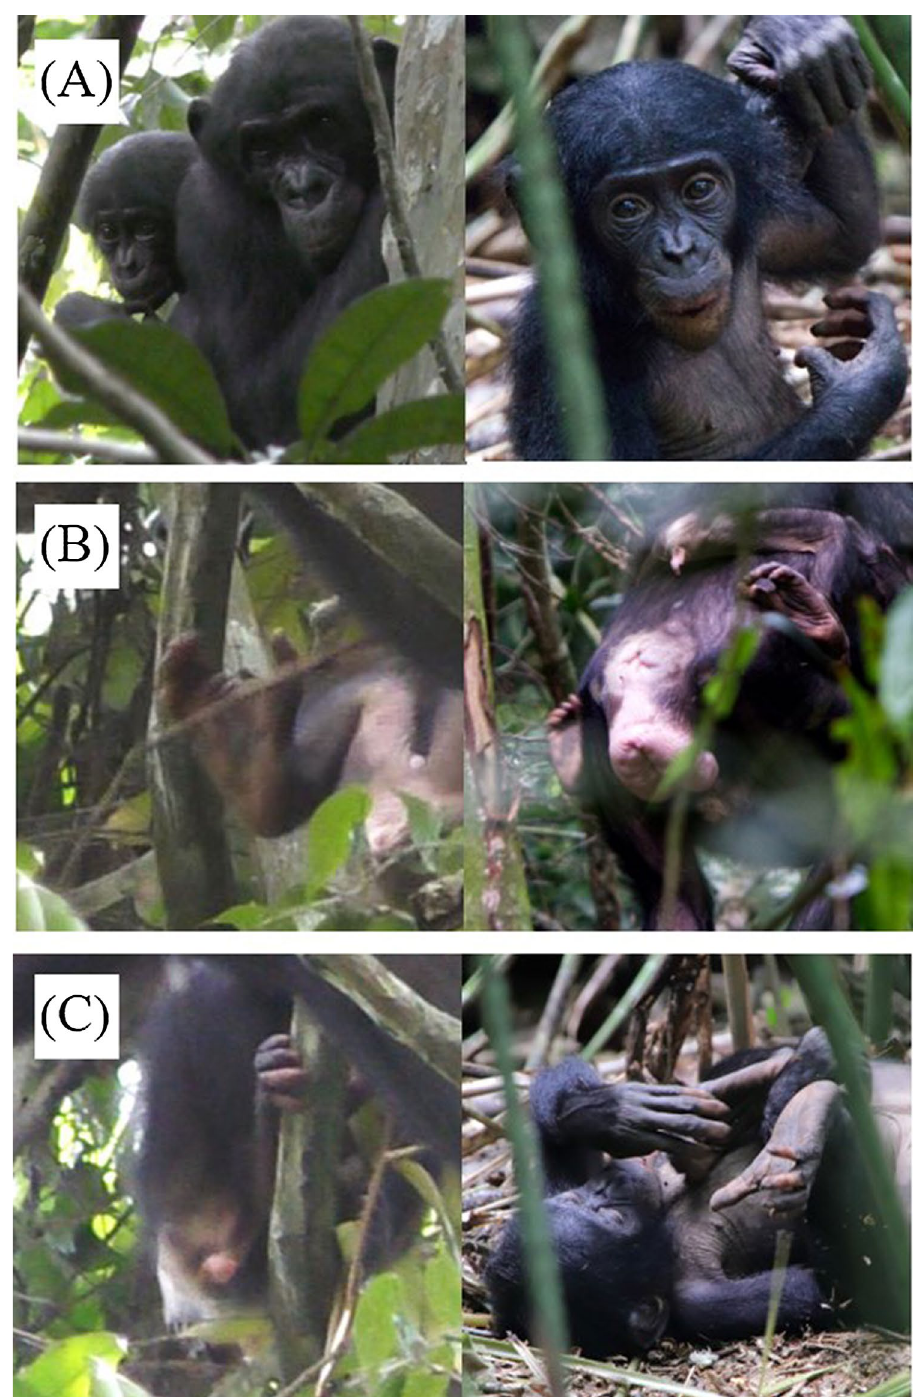
Figure 2. Flora in 2017 (left) and in 2019 (right). ( A ) Facial features include a distinctive U-shaped curve under her nose and raised bumps at the inside corners of her eyebrow ridge. ( B ) Color patterns on the bottom of her right foot, with darker blotches along the inside crease. ( C ) Color patterns of her fingers on her right foot. Her fourth and fifth fingers are pink, and her third finger is